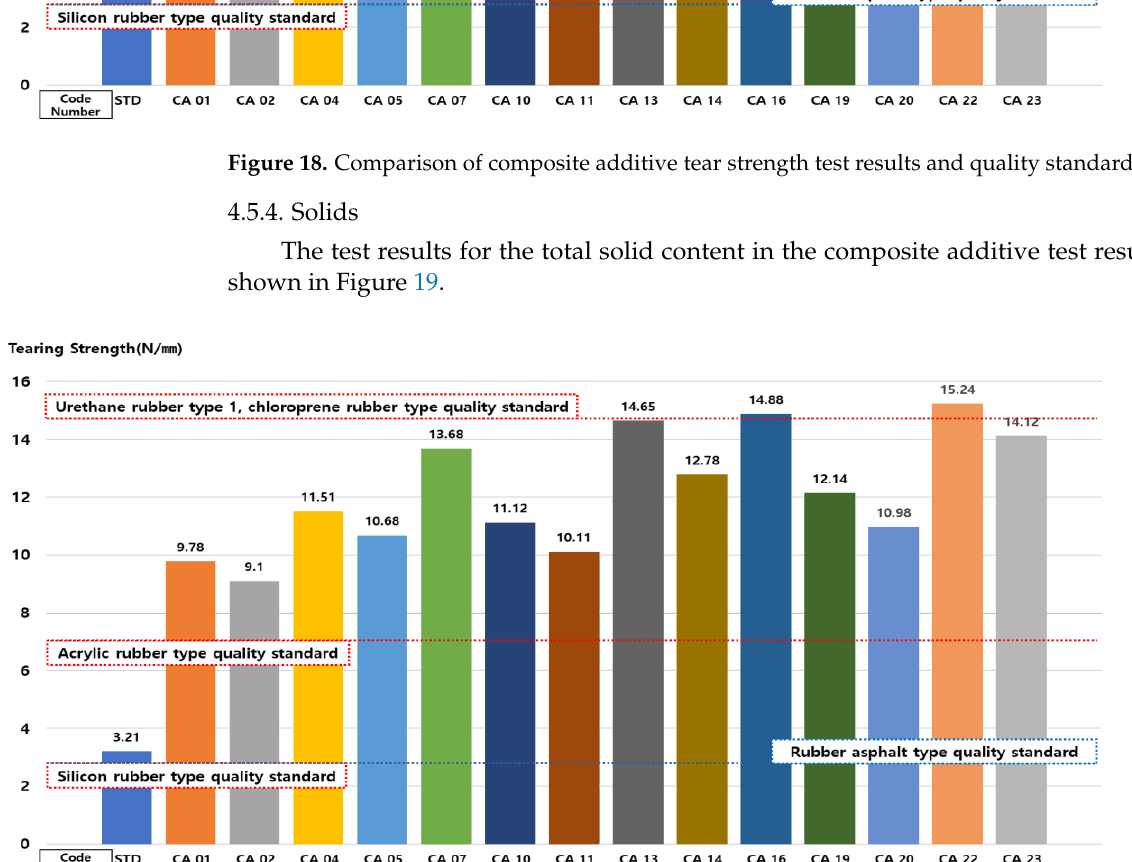
Figure 19. Composite additive solid content test result. As a result of applying the composite additive to the rubber-asphalt-based water- proofing material used in this study, the minimum solid content was increased by about 121% to 88.67%, and the maximum solid content was increased by about 126% to 92.67%. There is no separate quality standard for these solids, but since it is possible to predict the degree of decrease in the thickness of the waterproofing layer due to hardening after the on-site casting of the waterproofing material, the mixing ratio with a solid content of 90% or more is CA 05, CA 07, CA 11, CA 13, and CA 14, as well as CA 16, CA 20, CA 21, CA